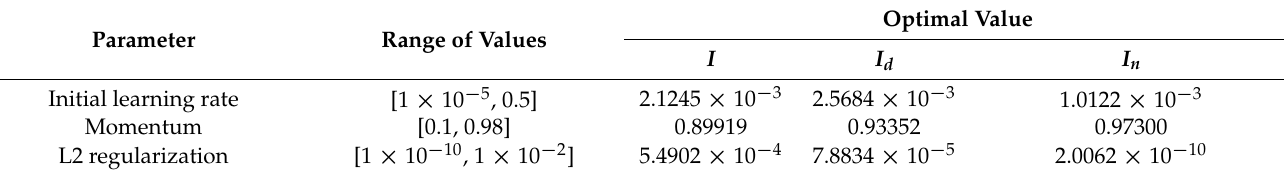
Table 2. Estimated hyperparameters via Bayesian optimization.